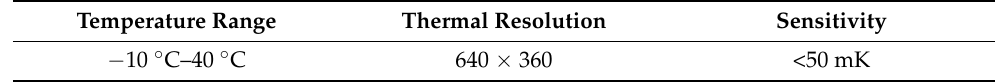
Table 1. IR device specification.